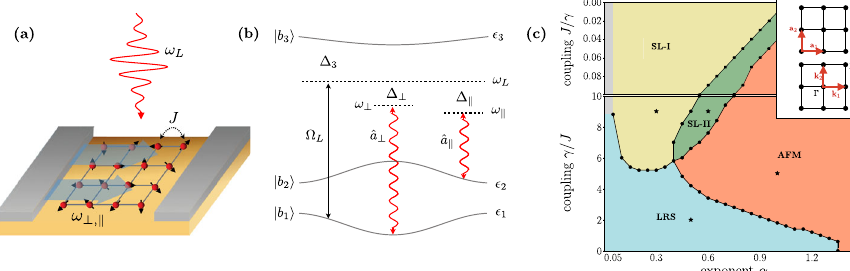
Fig. 1 Implementation of a cavity-induced quantum spin liquid and phase diagram. a Setup: a two-dimensional material, with nearest-neighbour exchange interaction J , is coupled to a cavity with fundamental frequencies ω ⊥ , ∥ , whose fi eld is represented by the light-blue arrows. The system is driven by an external laser with frequency ω L . b Level scheme: the electronic orbitals j b ~ ϵ 3 via the laser with Rabi frequency Ω L and the cavity modes a ⊥ , ∥ . The third band is detuned from the laser by Δ 3 , and from the cavity modes by Δ ⊥ , ∥ . c Phase diagram for the ground state of Hamiltonian (1), obtained from the bosonic spinon decomposition, as a function of the exponent α and of the coupling ratio γ / J , featuring spin-liquid (SL), long-range-single (LRS) and antiferromagnetic (AFM) phases. Error bars on the phase boundaries are within the symbols ’ size. The inset shows the square lattice and the reciprocal one, with the respective primitive